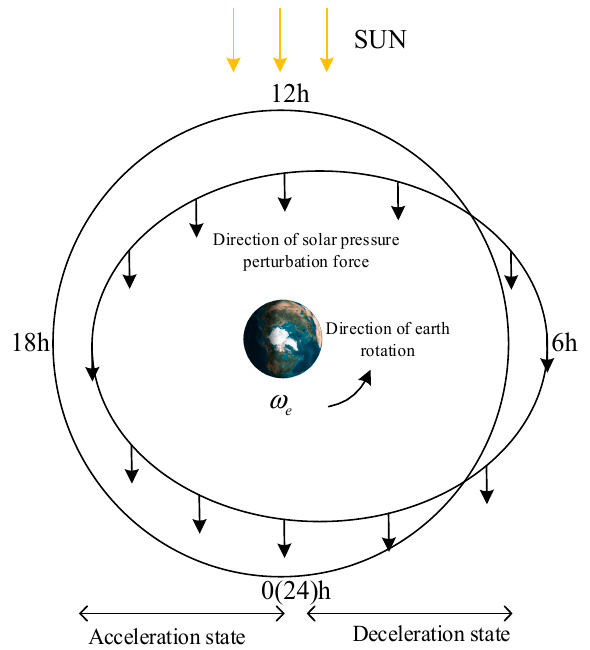
Figure 1. Schematic diagram of the influence of solar light pressure perturbation on the eccentricity vector of GEO satellites ( viewed from the Earth’s North Pole ).